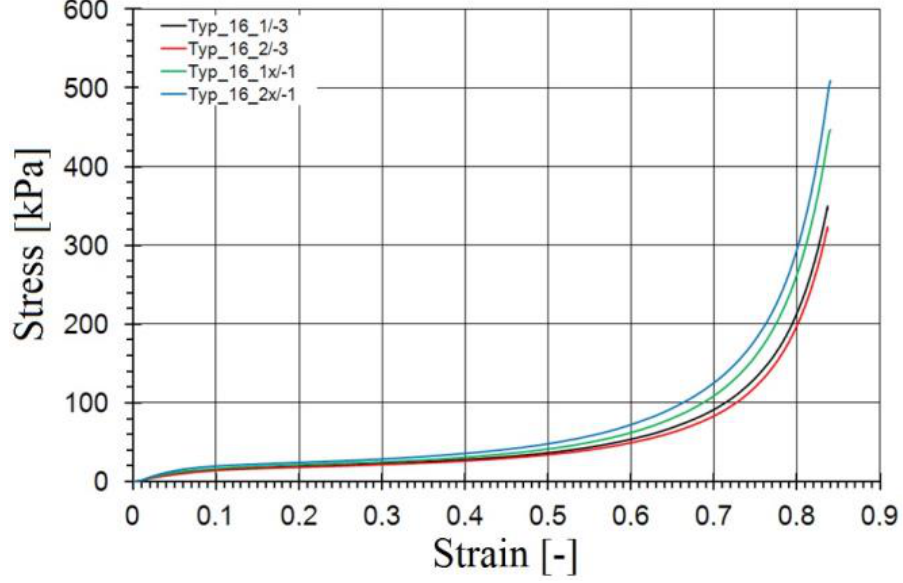
Figure 2. Stress vs. volumetric strain curves for seat foams, based on [23].